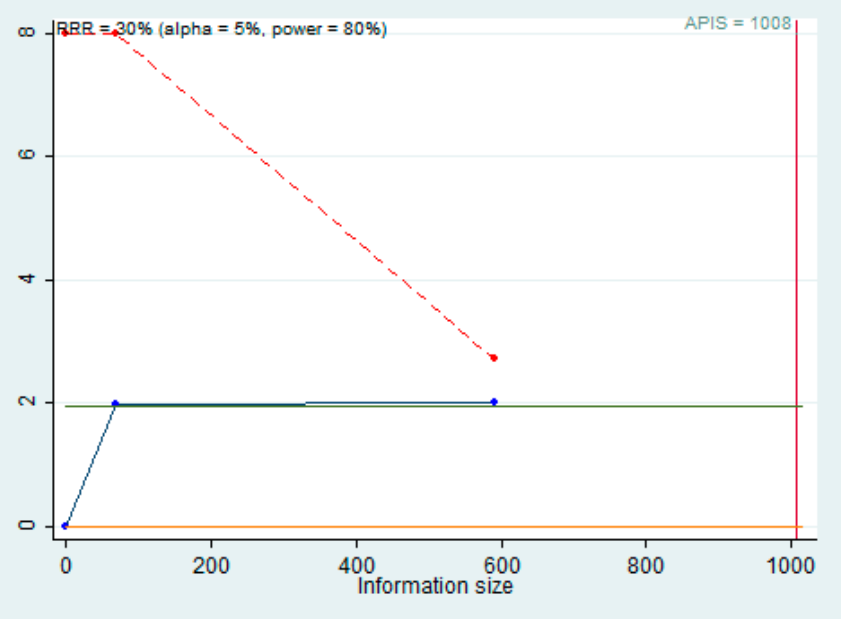
Figure 6. APIS, light green line (Z = 1.98); dashed red line (monitoring boundary); blue line (cumulative z curve); red line (sample size).